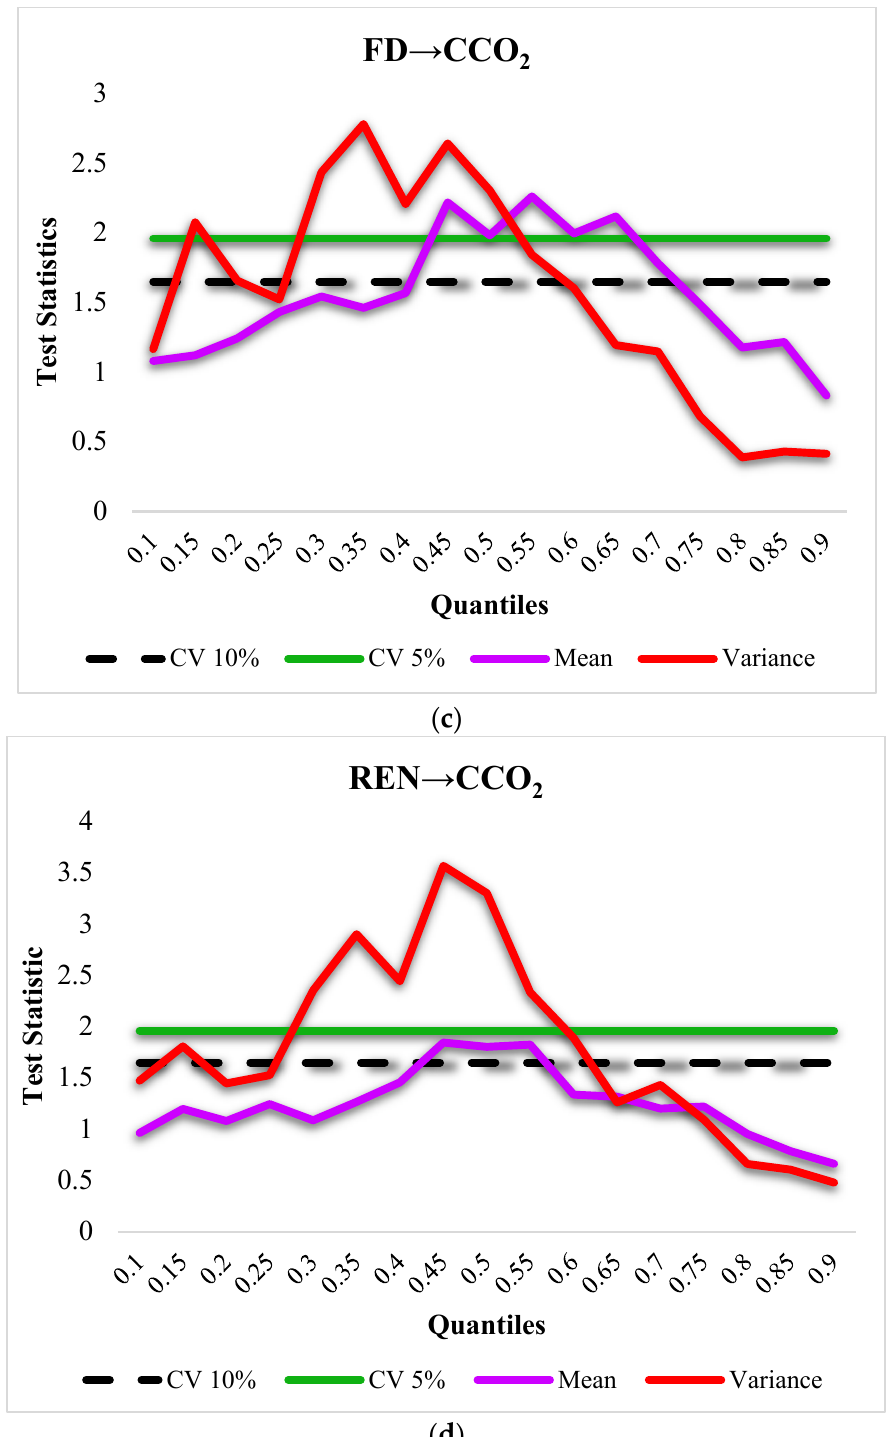
Figure 3. ( a ) Causality from EXP to CCO 2 ; ( b ) causality from IMP to CCO 2 ; ( c ) causality from REC to CCO 2 ; ( d ) causality from FD to CCO 2 . Table 6. Causality in mean and variance.